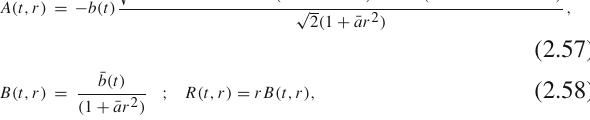
Fig. 3 a Plot of the expansion scalar (cid:9) , equation (2.55), with respect to t and r . For the collapsing phenomena (cid:9) should be negative through- out the collapse which is confirmed from the figure that as the collapse starts at t = − 100, (cid:9) has zero value and it starts decreasing till the